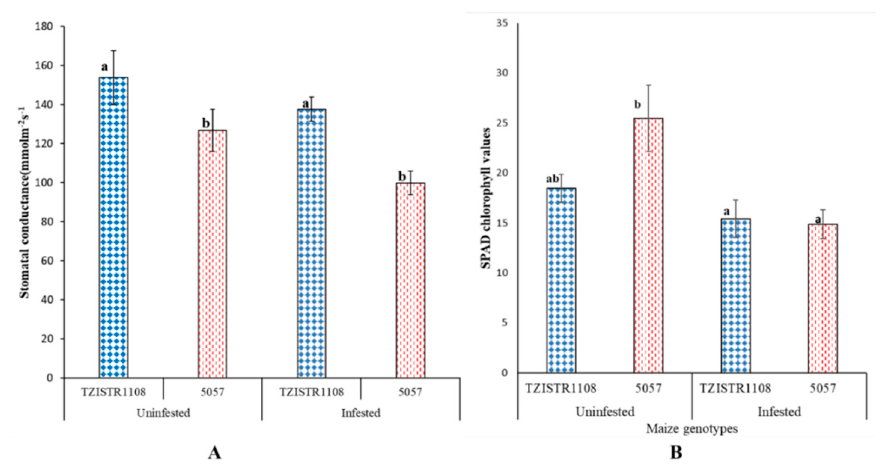
Figure 6. Physiological parameters upon infestation and without infestation. ( A ). Average stomatal conductance of both lines with and without infestation. ( B ). Average chlorophyll content of both lines with and without infestation. The different letters (a and b) show significant differences among groups at α = 0.05. The bars show standard error.